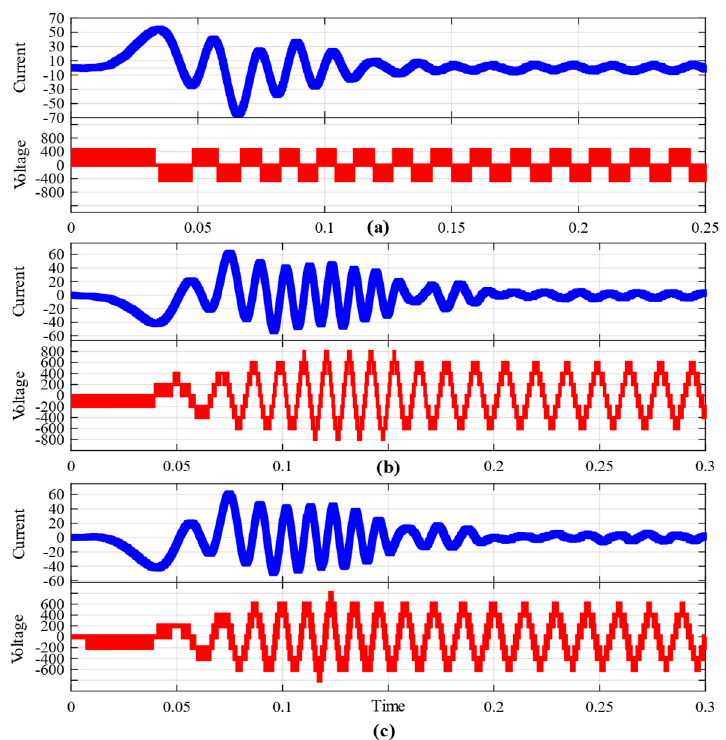
Figure 37. Output current-voltage waveforms of a DC–AC inverter: ( a ) two-level inverter with SVPWM; ( b ) seven-level inverter; and ( c ) seven-level THI inverter.